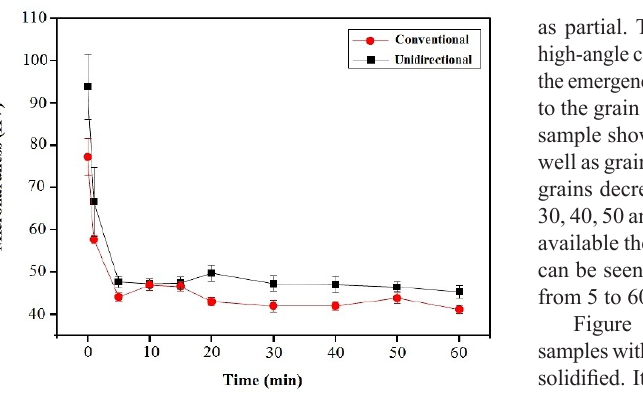
Figure 10. Microhardness after recrystallization kinetics at 350 ºC of the Al4.5wt%Cu sample with 91% of RA conventionally and unidirectionally